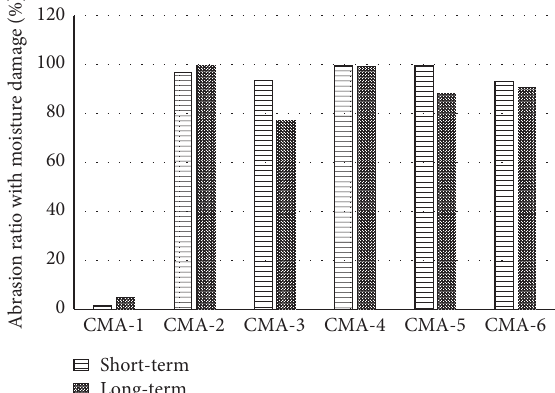
Figure 11: Abrasion ratio for short- and long-term performance with moisture